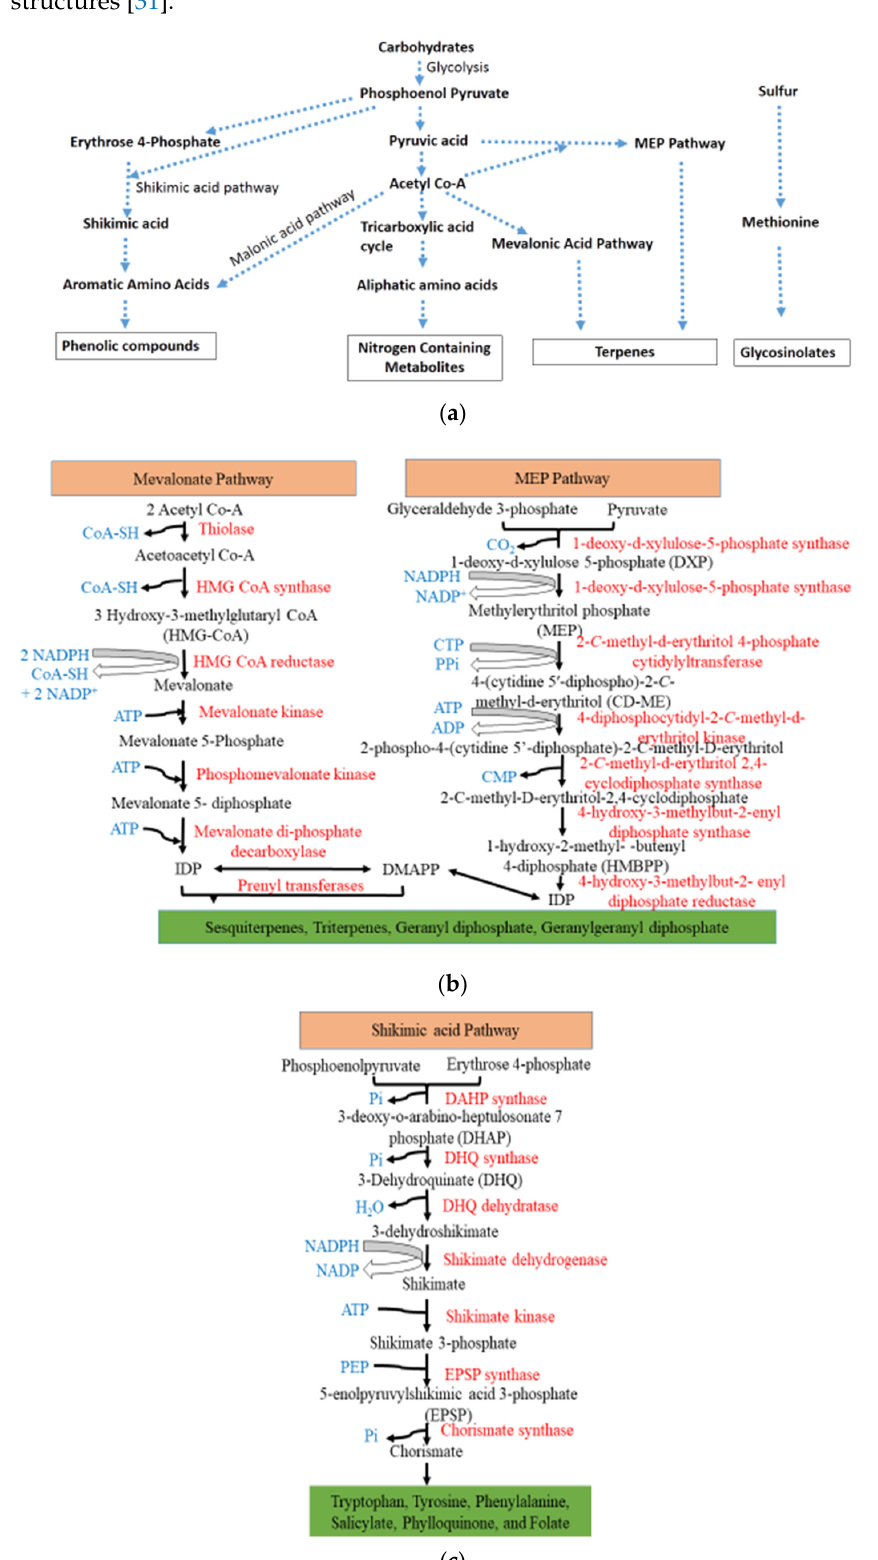
Figure 2. ( a ) Biosynthesis pathways of phenolic, nitrogen and sulfur containing compounds. ( b ) Terpenoid biosynthesis pathway in plants. ( c ) Phenolic biosynthesis pathway in plants.